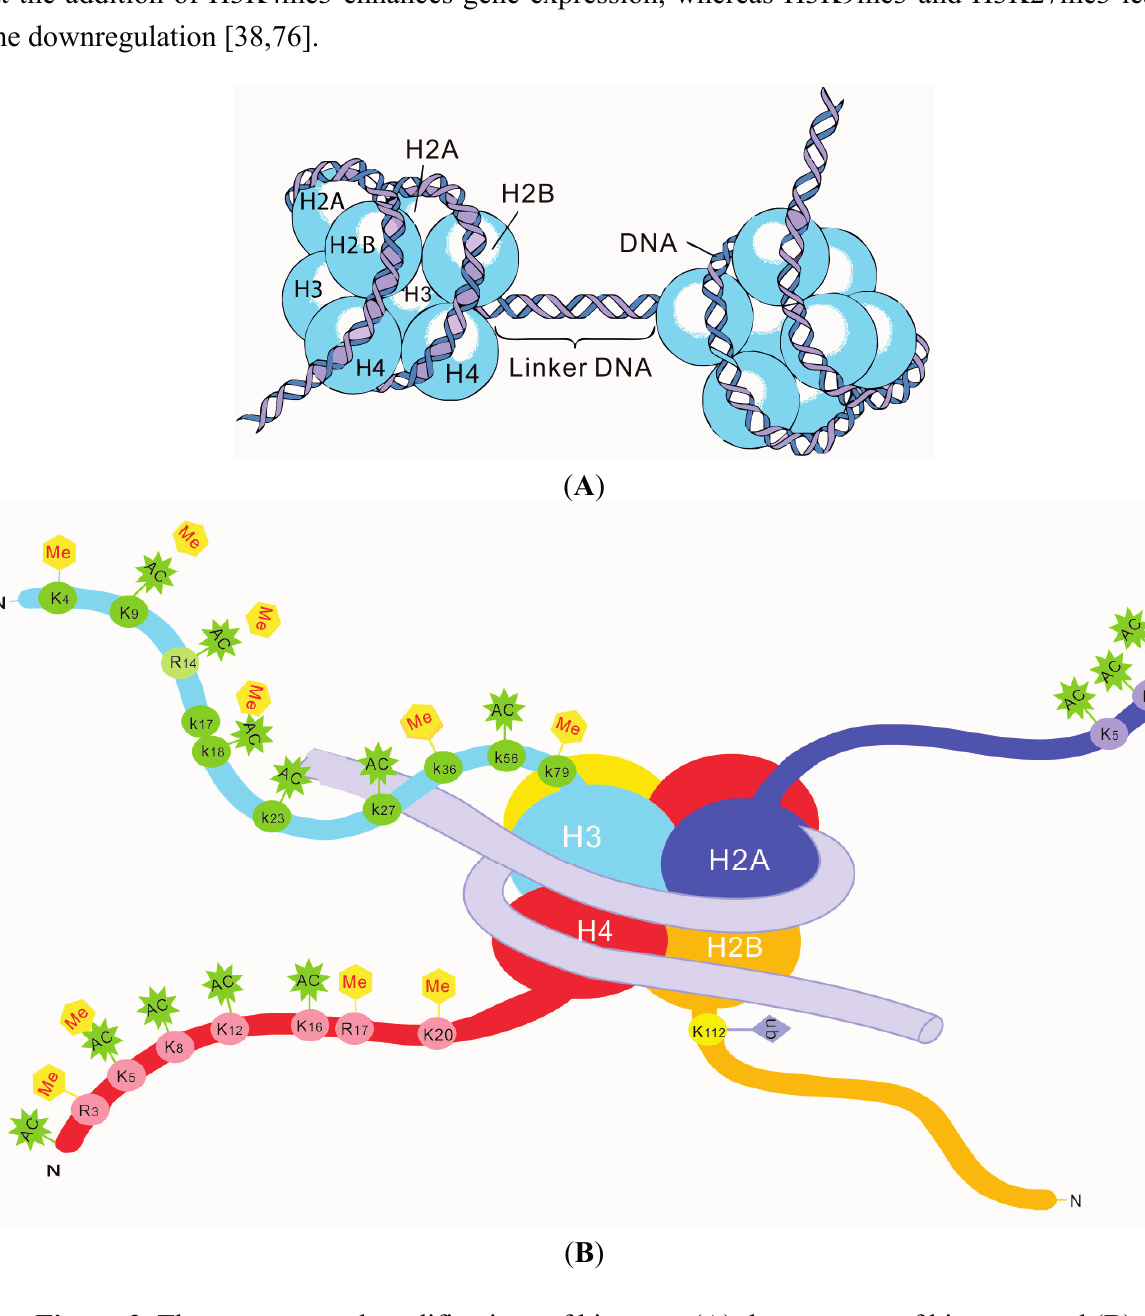
Figure 3. The structure and modifications of histones: ( A ) the structure of histones; and ( B ) the various modifications of histones. Me: Methylation; AC: Acetylation; Ub: